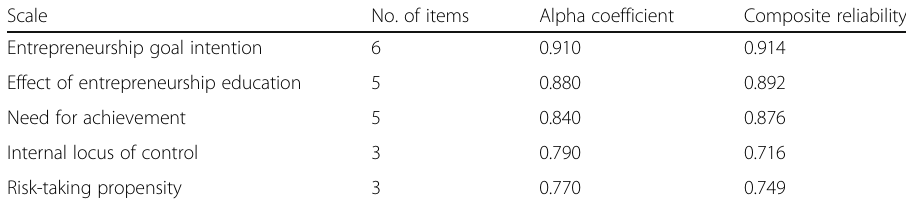
Table 1 Reliability test